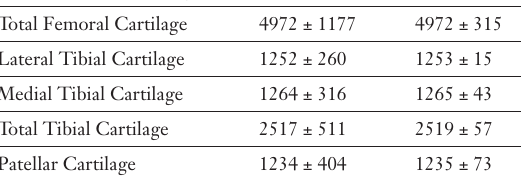
The crude and ad- justed total femoral, tibial and patellar cartilage volumes.